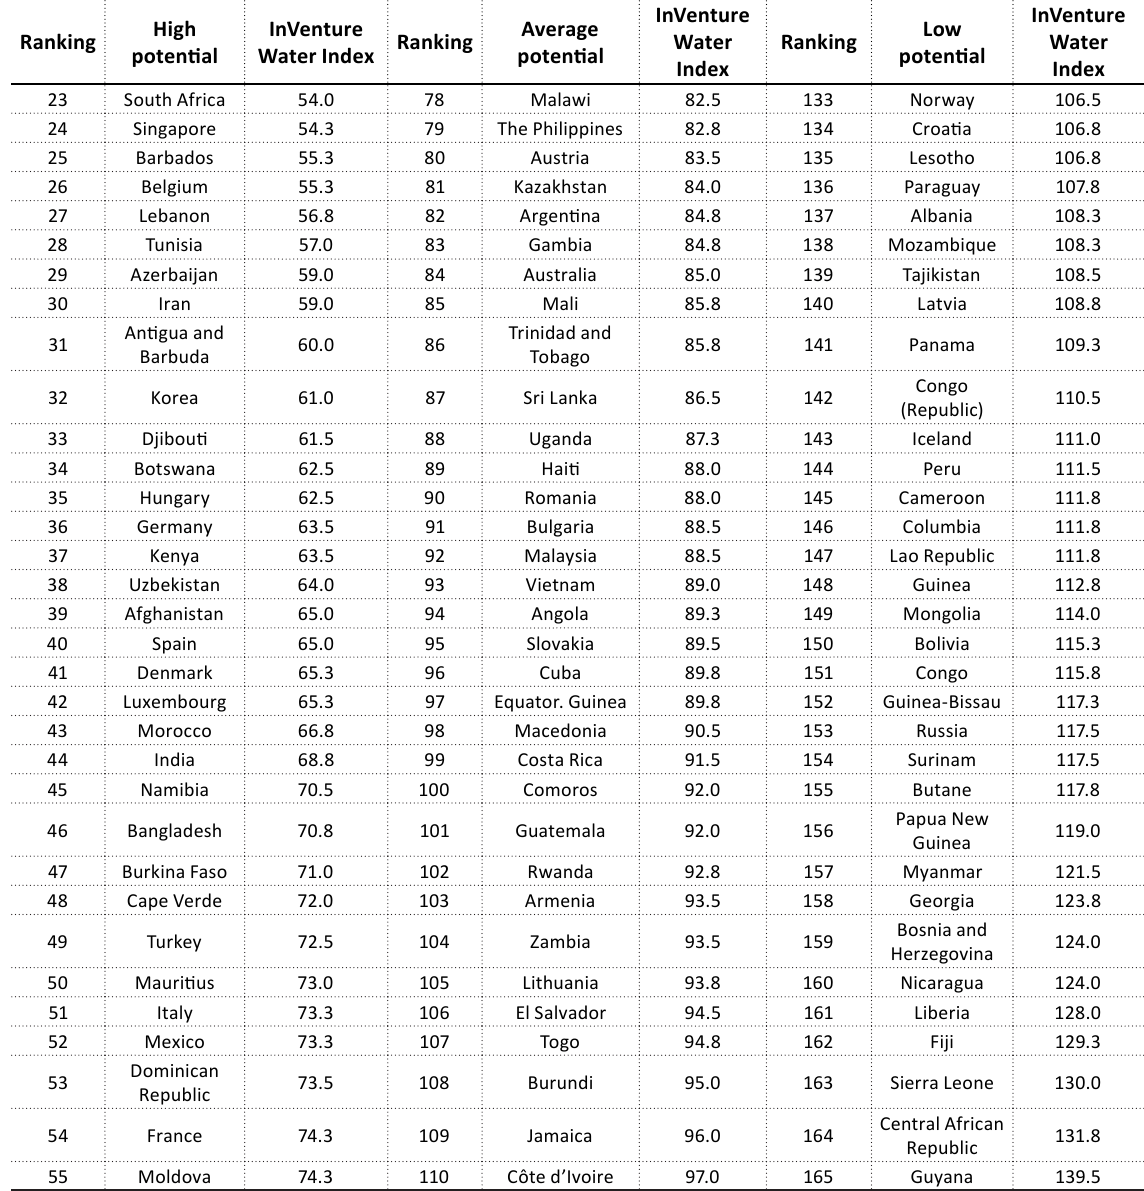
Table A2 (cont.). Rating of investment-attractive countries in the context of the relevance of water production/water supply